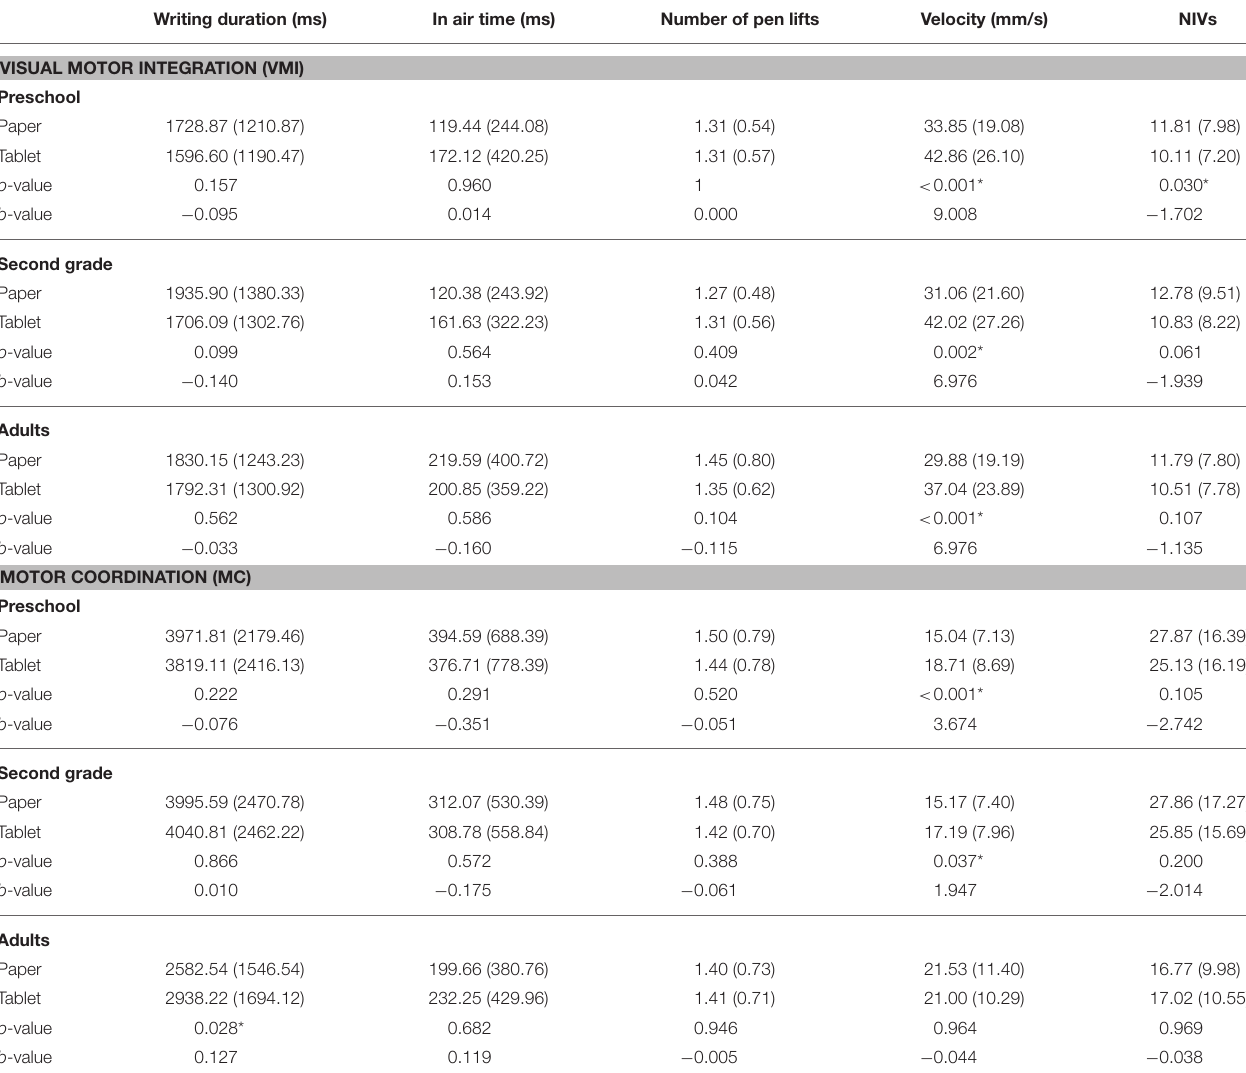
TABLE 3 | Means and standard deviations in parentheses for writing measures of the visuomotor